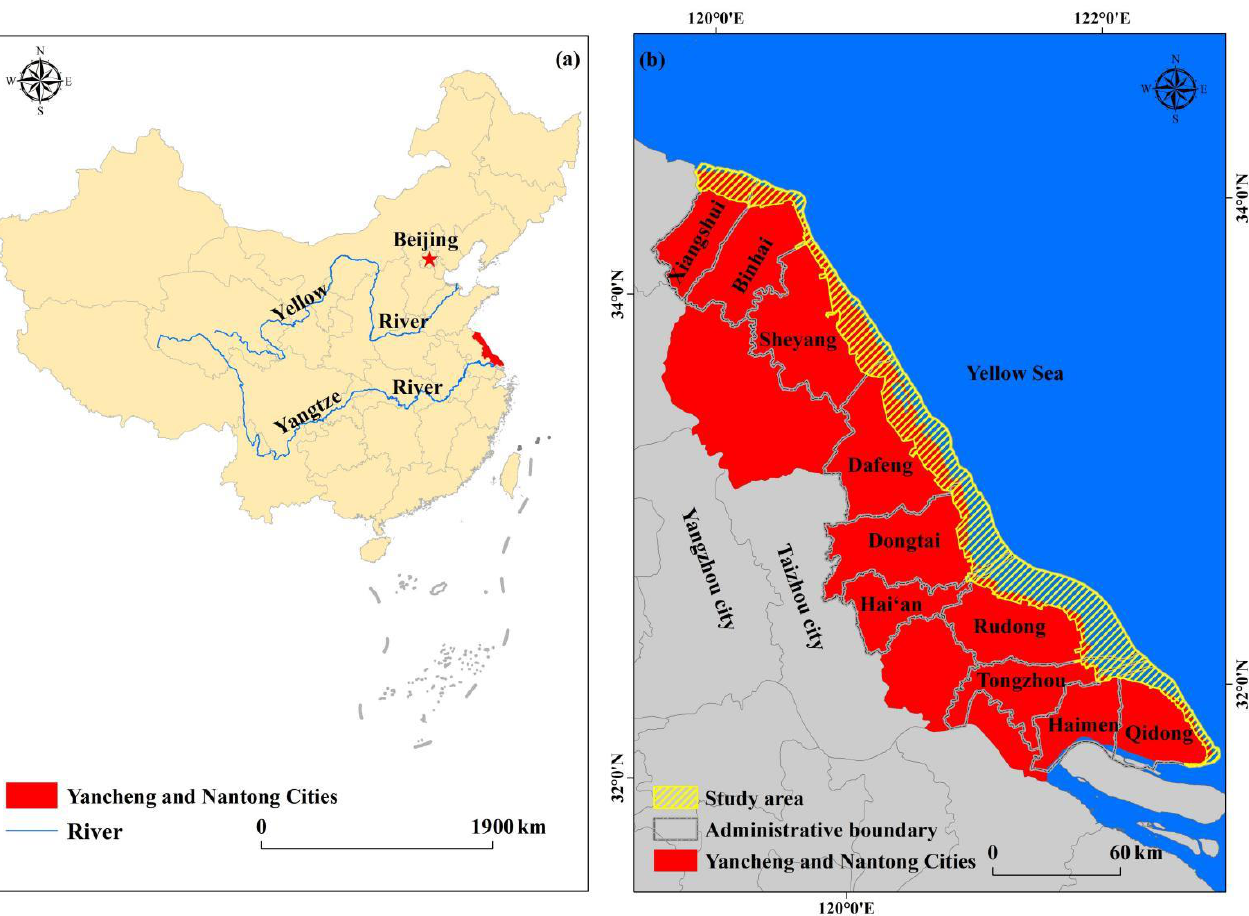
Figure 1. Location and extent of the research area, ( a ) locations of Yancheng and Nantong cities in China, ( b ) specific location of the study area in Yancheng and Nantong cities.